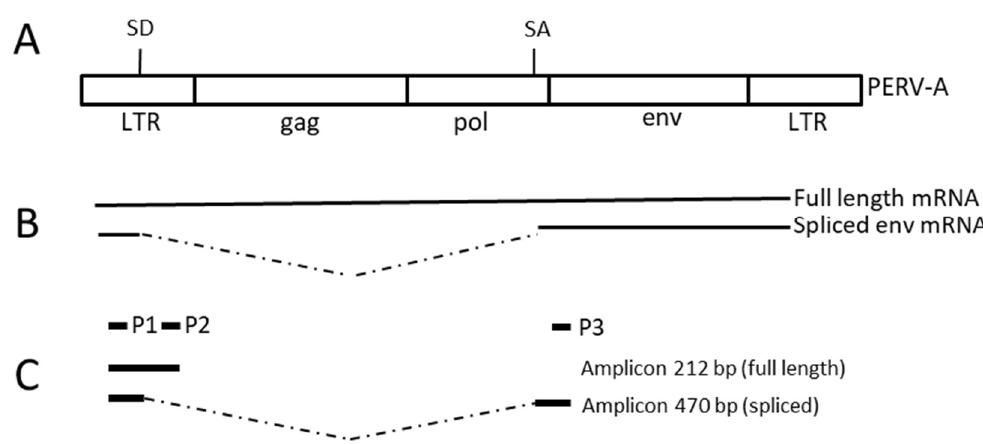
Figure 2. ( A ), Genomic organisation of PERV proviruses, ( B ), transcription of the full-length mRNA (coding for the Gag proteins and the enzymes) and the spliced mRNA (coding for the envelope proteins only), ( C ), localisation of the primers P1, P2 and P3 to amplify the spliced mRNA by RT-PCR and length of the amplicons [23] (Table 2). SD, splice donor; SA, splice acceptor; LTR, long terminal repeat; gag, pol, env, sequences coding for the Gag, Pol and Env proteins; bp, base pairs.